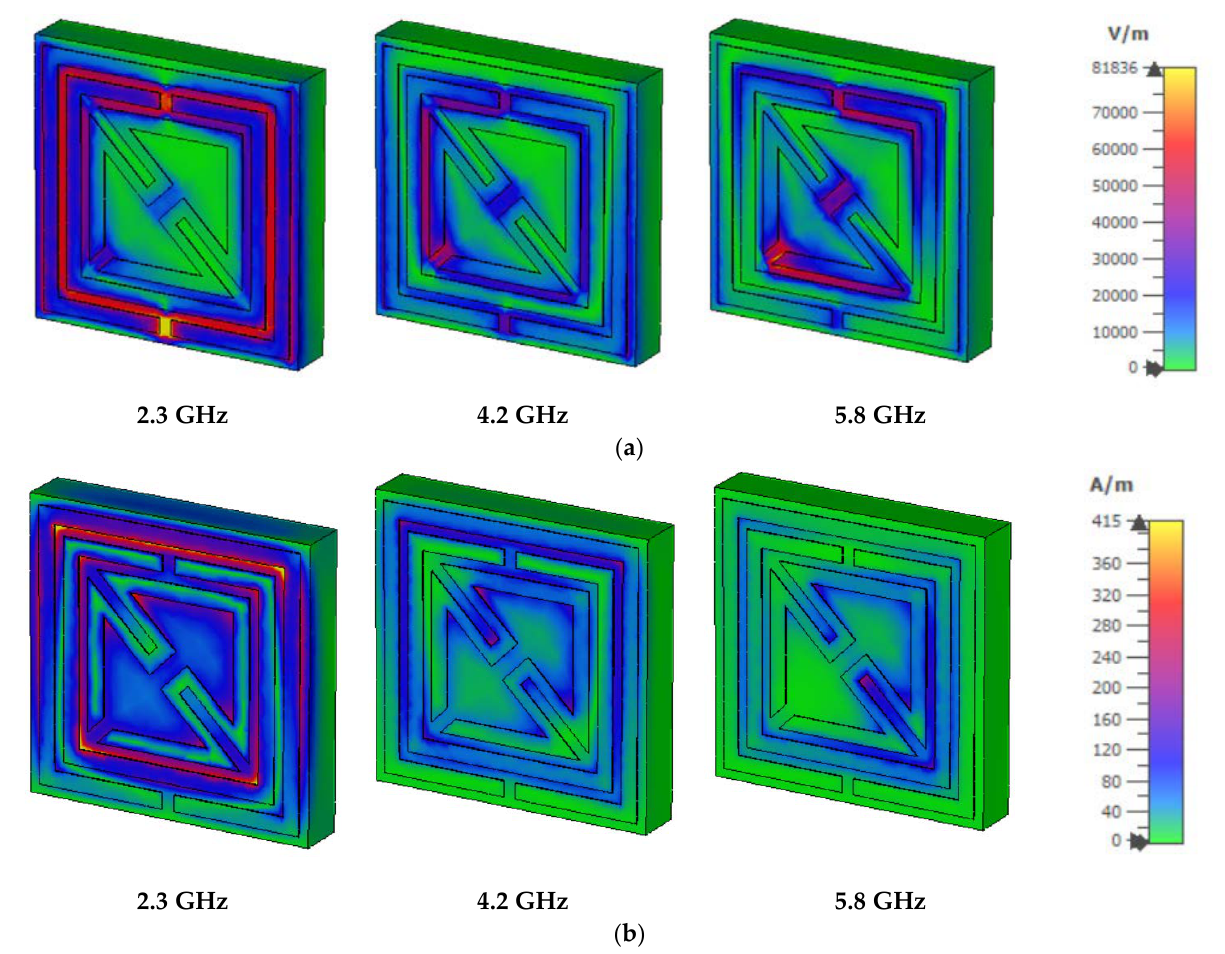
Figure 10. Electric ( a ) and magnetic field ( b ) distribution at 2.3, 4.2, and 5.8